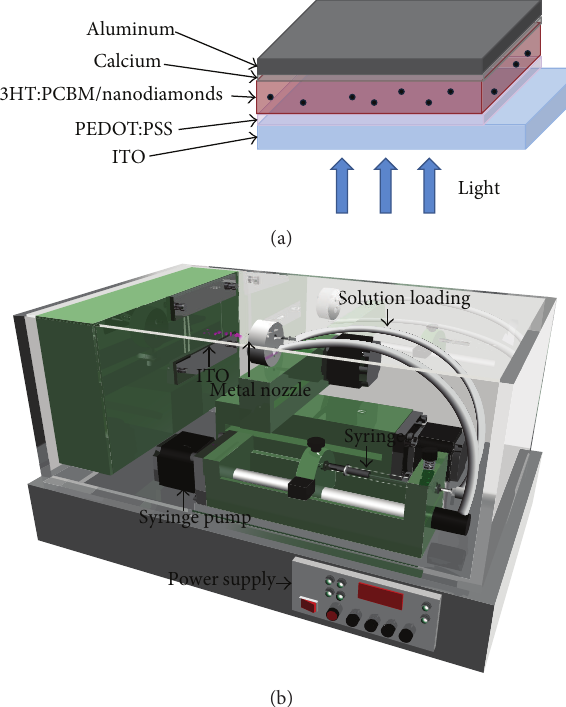
Figure 1: Schematics of (a) device structure with P3HT:PCBM/na- nodiamond as the active layer and (b) e-spray method.